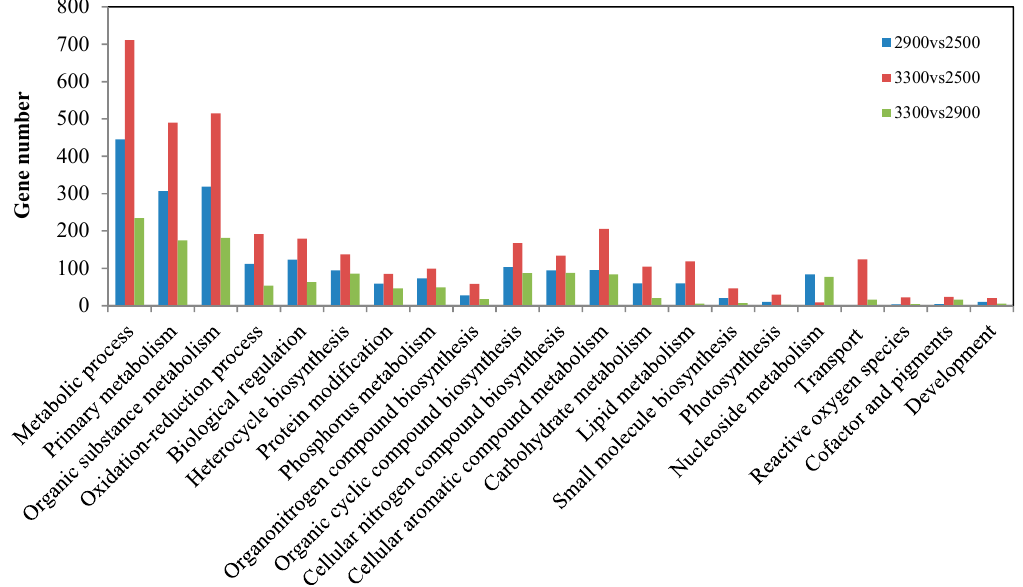
Figure 6. Gene Ontology (GO) term enrichment in Picea crassifolia with elevations.